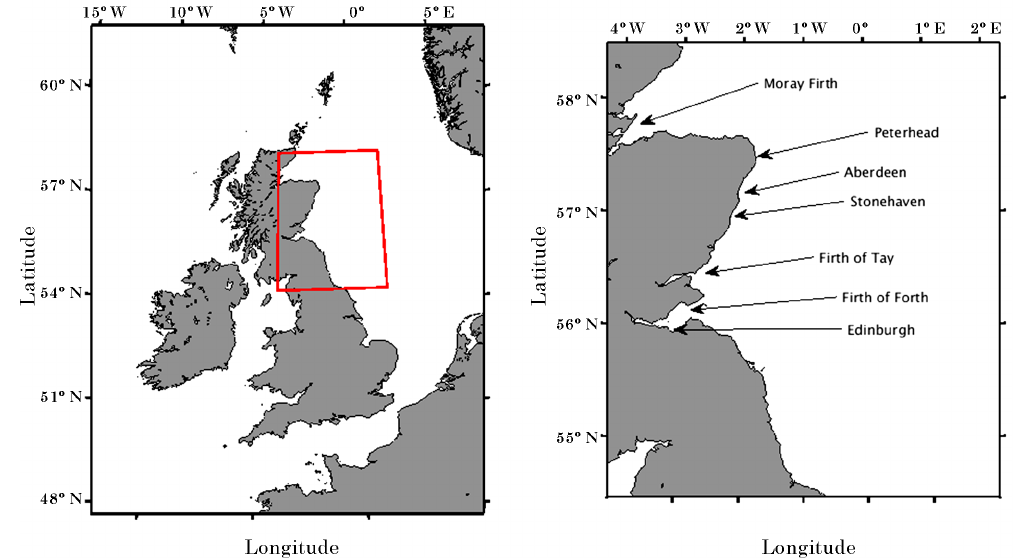
Figure 1. The area studied in the present paper.